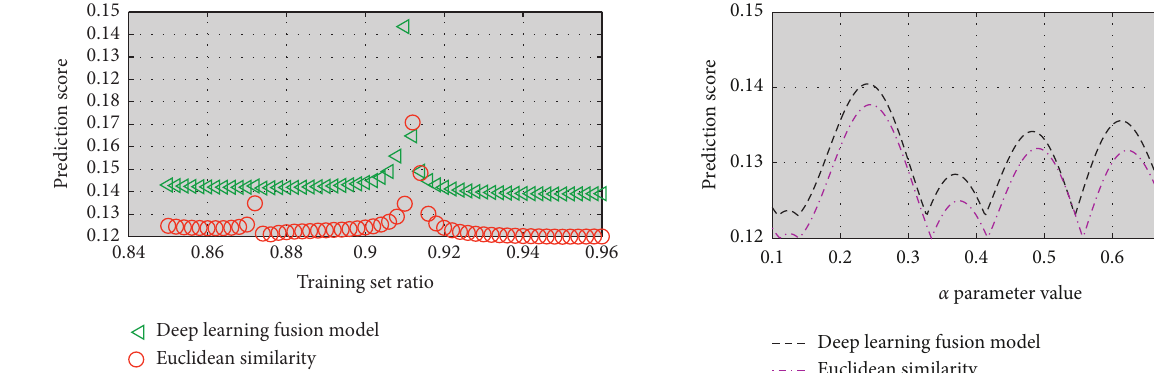
Figure 5: The change curve of the predicted score MAE after case- based reasoning under different α parameters.